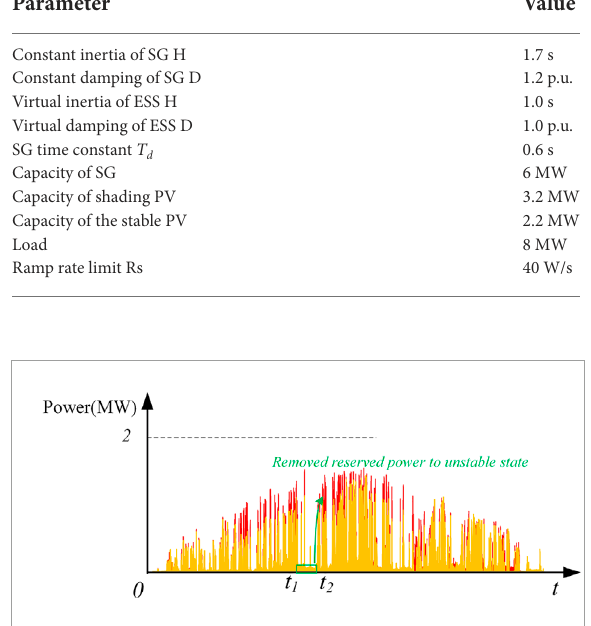
FIGURE 13 Reserved power of the determined forecast and AFB-VIC probabilistic forecast reserve strategy.